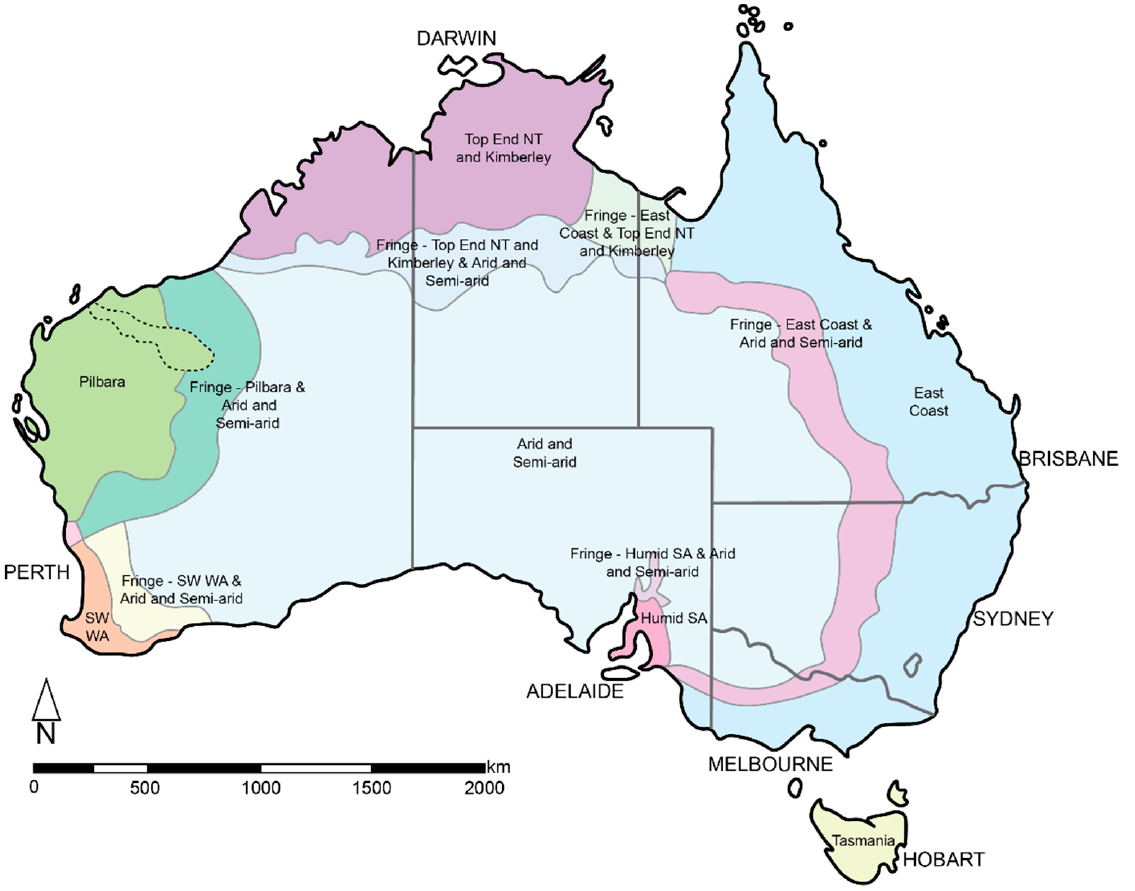
Figure 3. Adopted regions for RFFE technique in Australia. Modified from Rahman et al., (2019) [52]. The Fortescue Catchment, Pilbara is outlined.